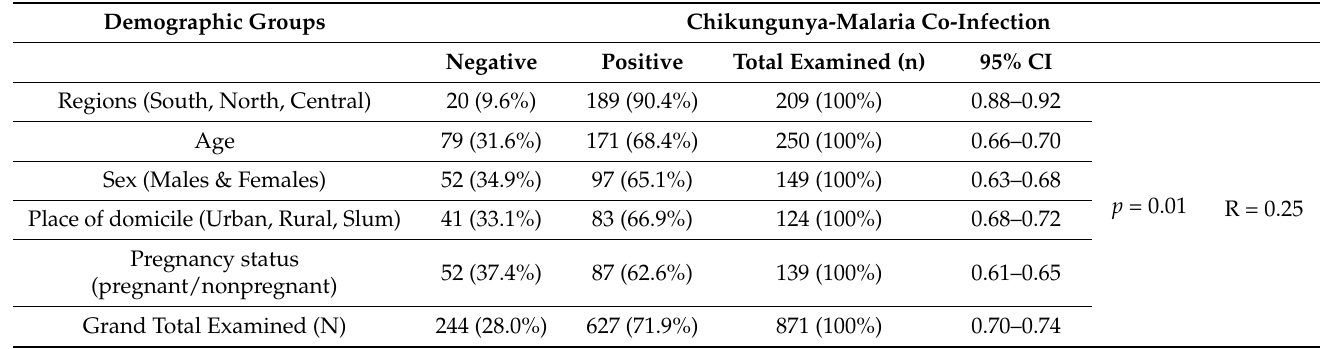
Table 2. Seroprevalence of chikungunya–malaria coinfection in the study population. Demographic